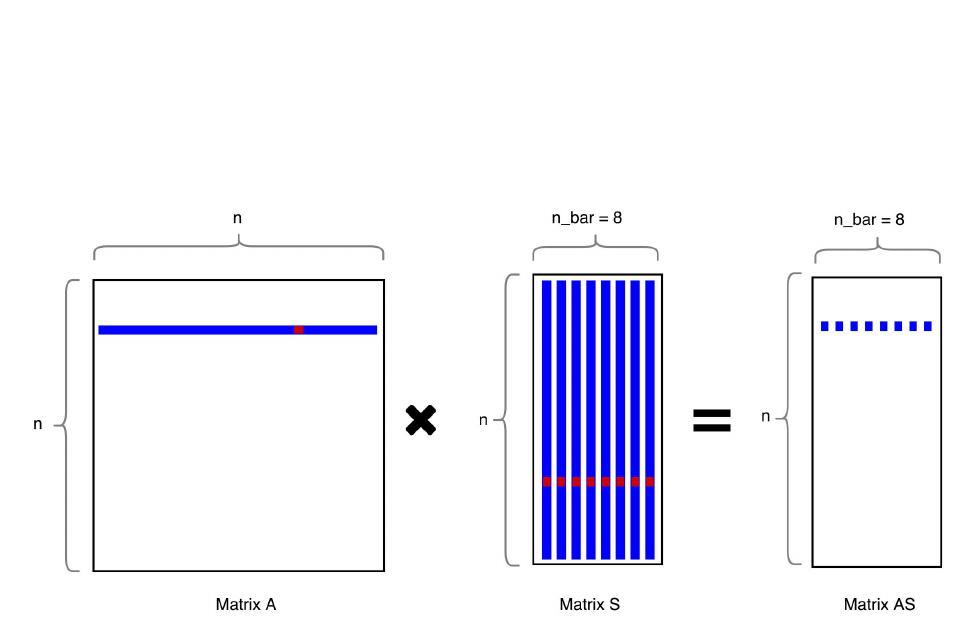
Figure 5: Concept of the multiplication of one row of A with S effectively. Blue entries are affected by one function call, red entries are loaded during one iteration.